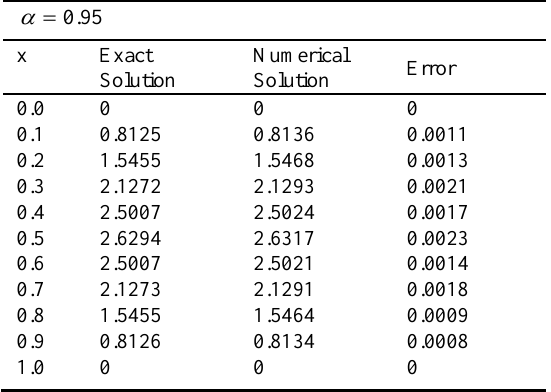
Table 3. Numerical results for